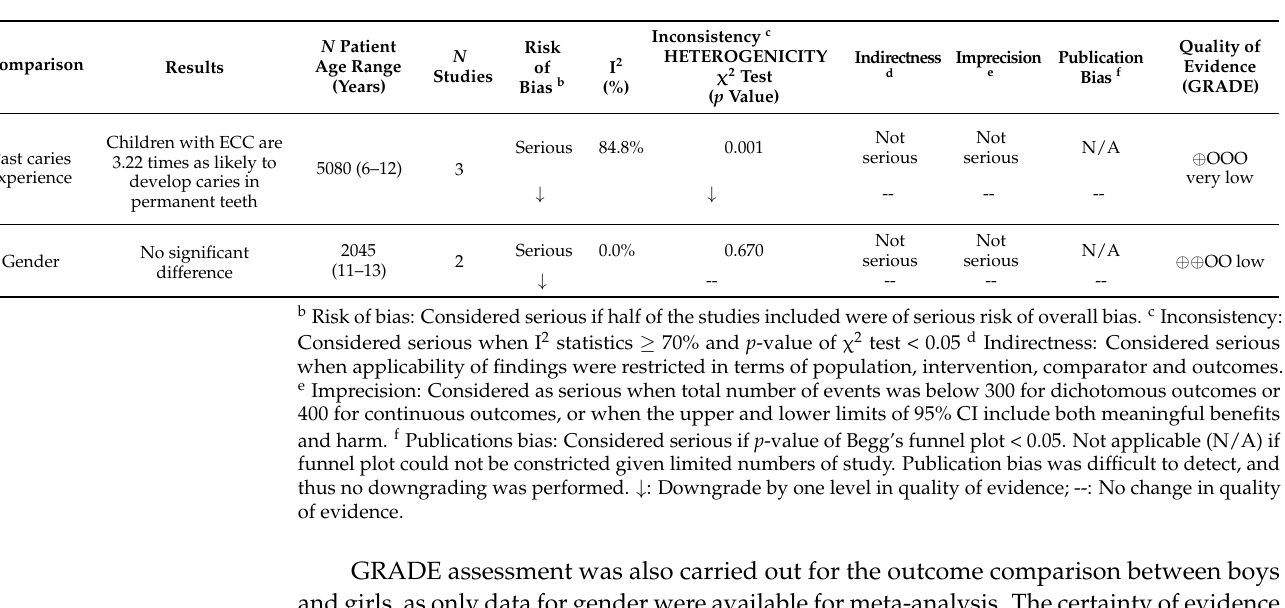
Table 2. GRADE summary of